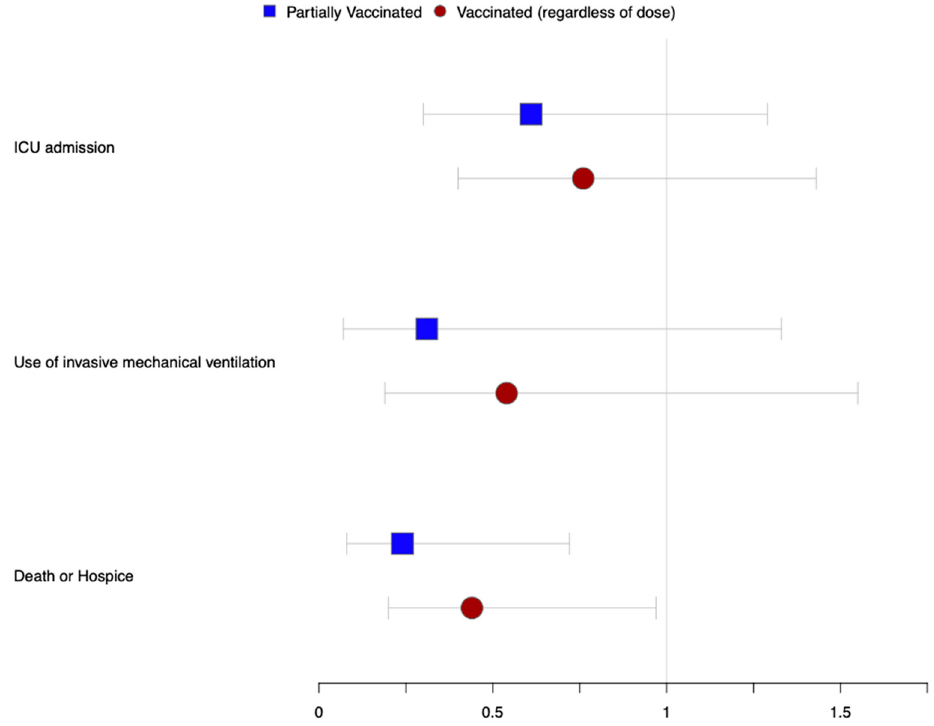
Figure 1. Association of prior COVID vaccination with hospitalization outcomes. Table 3. Association of prior COVID vaccination with hospitalization outcomes. * Odds Ratio (95% Confidence Interval)